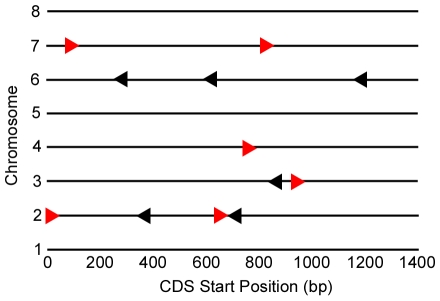
Distribution of C. parvum heat shock genes by chromosome.The symbols represent the positions of each of the 12 single copy HSP genes on the eight C. hominis chromosomes. Genes oriented (5′ to 32) left to right are indicated by red triangles oriented to the right; genes oriented in the opposite orientation are indicated by black triangles oriented to the left.